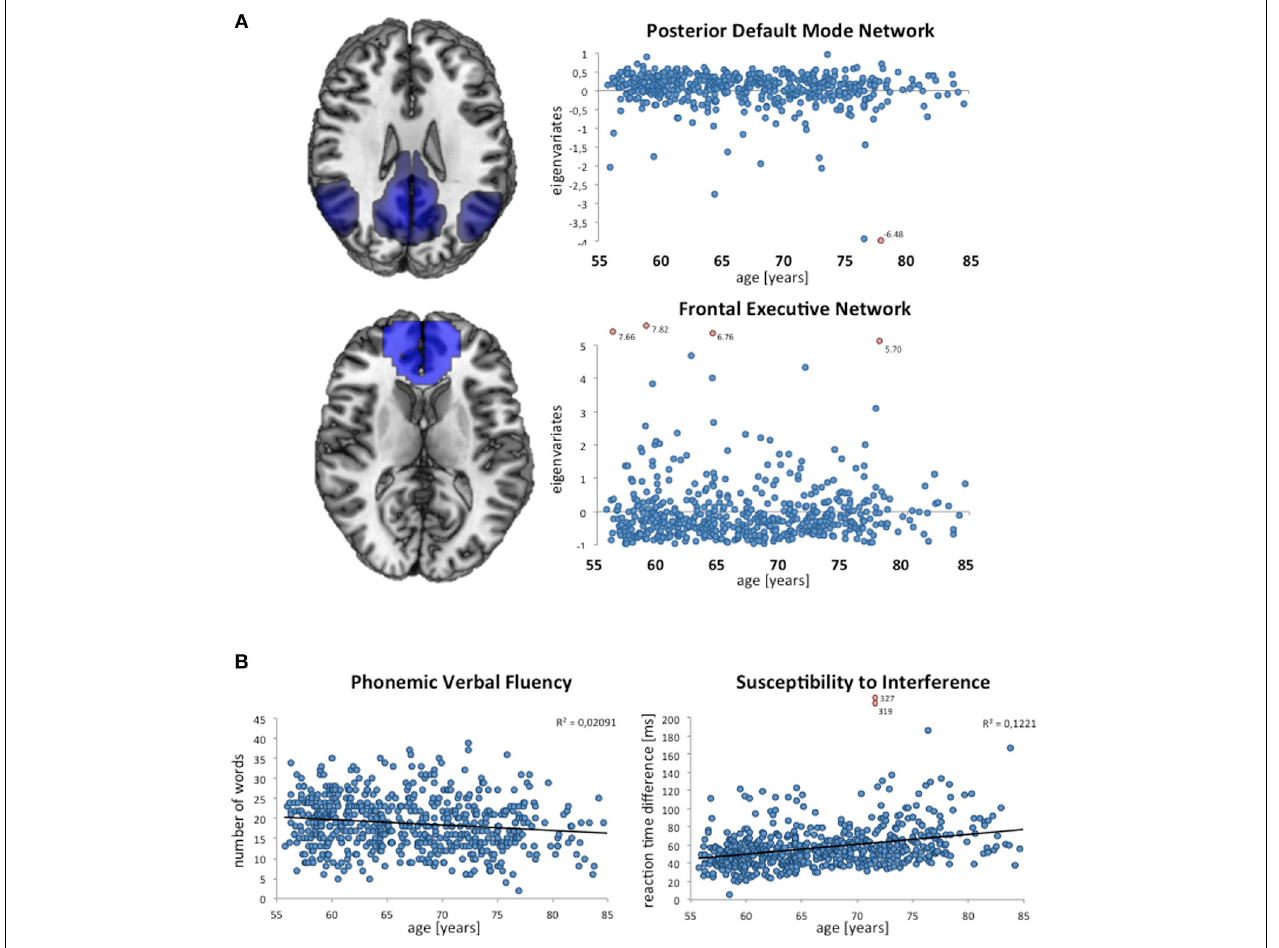
FIGURE 3 | Exemplary depictions of interindividual variability in phenotypes assessed in 1000BRAINS. (A) Composition of resting-state networks and their variability with age, as expressed via the individual eigenvariates (ICA decomposition using MELODIC; Beckmann and Smith, 2004) within FSL (http://www.fmrib.ox.ac.uk/fsl), displayed for the posterior part of the default mode network and the frontal executive network. (B